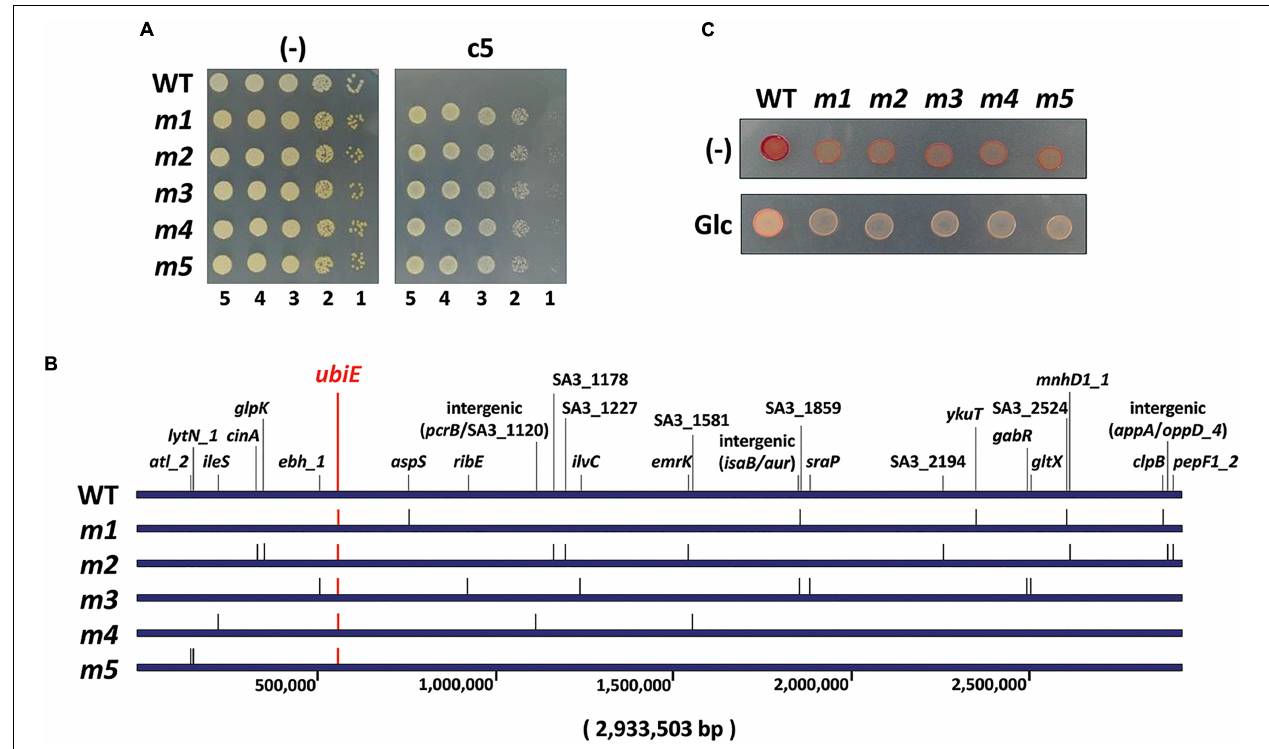
FIGURE 4 | Antibacterial resistance. (A) Resistance of spontaneous mutants ( m1 ∼ m5 ) to c5. The wild type (WT) SA3 and its c5-resistant mutant ( m1 ∼ m5 ) cells were grown to the logarithmic growth phase, and then ten-fold serial dilutions from the cells were spotted onto an LB agar plate (–) and LB agar plate containing 5.0 µ g/ml of c5. (B) Schematic representation of the mutation genes on the genome coordinates of the c5-resistant mutants ( m1 ∼ m5 ) in comparison with the 2,933,503-bp SA3 genome. The number indicates the relative nucleotide position of each genome. (C) Respiration activity of the c5-resistant mutants ( m1 ∼ m5 ) using 2,3,5-thriphenyl tetrazolium (TTC). The logarithmic growth phase cells of the wild type (WT) and c5-resistant mutant ( m1 ∼ m5 ) cells were spotted onto an LB agar plate containing 0.015% of TTC (–) and an LB agar plate containing 0.015% of TTC and 0.2% of glucose (Glc).